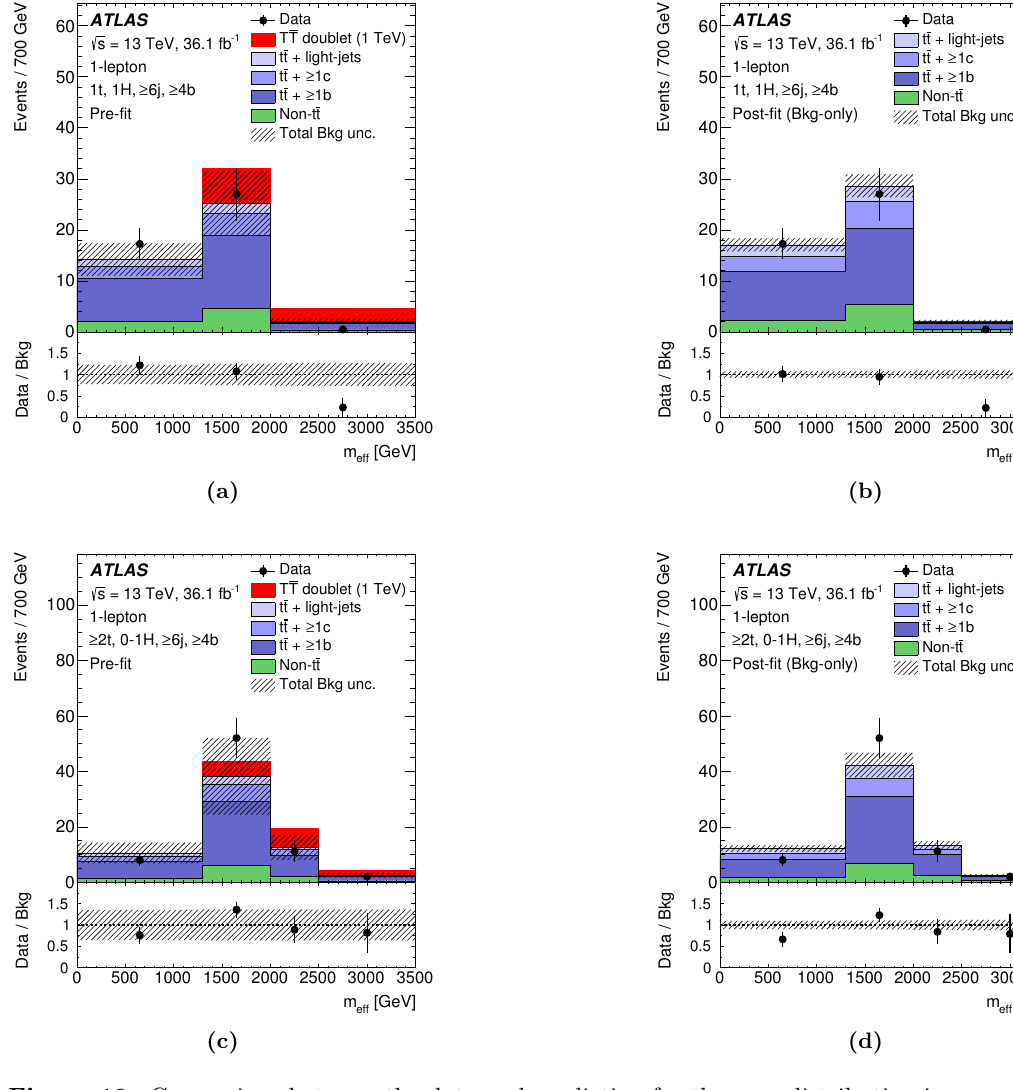
Figure 10. Comparison between the data and prediction for the m e(cid:11) distribution in some of the most sensitive search regions in the 1-lepton channel, before and after performing the combined (cid:12)t to data in the 0-lepton and 1-lepton channels (\Pre-(cid:12)t" and \Post-(cid:12)t", respectively) under the background-only hypothesis. Shown are the (1t, 1H, 6j, 4b) region (a) pre-(cid:12)t and (b) post-(cid:12)t, (cid:21) (cid:21) and the ( 2t, 0{1H, 6j, 4b) region (c) pre-(cid:12)t and (d) post-(cid:12)t. In the pre-(cid:12)t (cid:12)gures the expected (cid:21) (cid:21) (cid:21) T (cid:22) T signal (solid red) corresponding to m T = 1 TeV in the T doublet scenario is also shown, added on top of the background prediction. The small contributions from t (cid:22) tV , t (cid:22) tH , single-top, W=Z +jets, diboson, and multijet backgrounds are combined into a single background source referred to as \Non- t (cid:22) t ". The last bin in all (cid:12)gures contains the over(cid:13)ow. The bottom panels display the ratios of data to the total background prediction (\Bkg"). The blue triangles indicate points that are outside the vertical range of the (cid:12)gure. The hashed area represents the total uncertainty of the background. In the case of the pre-(cid:12)t background uncertainty, the normalisation uncertainty of the t (cid:22) t + 1 b background is not (cid:21)